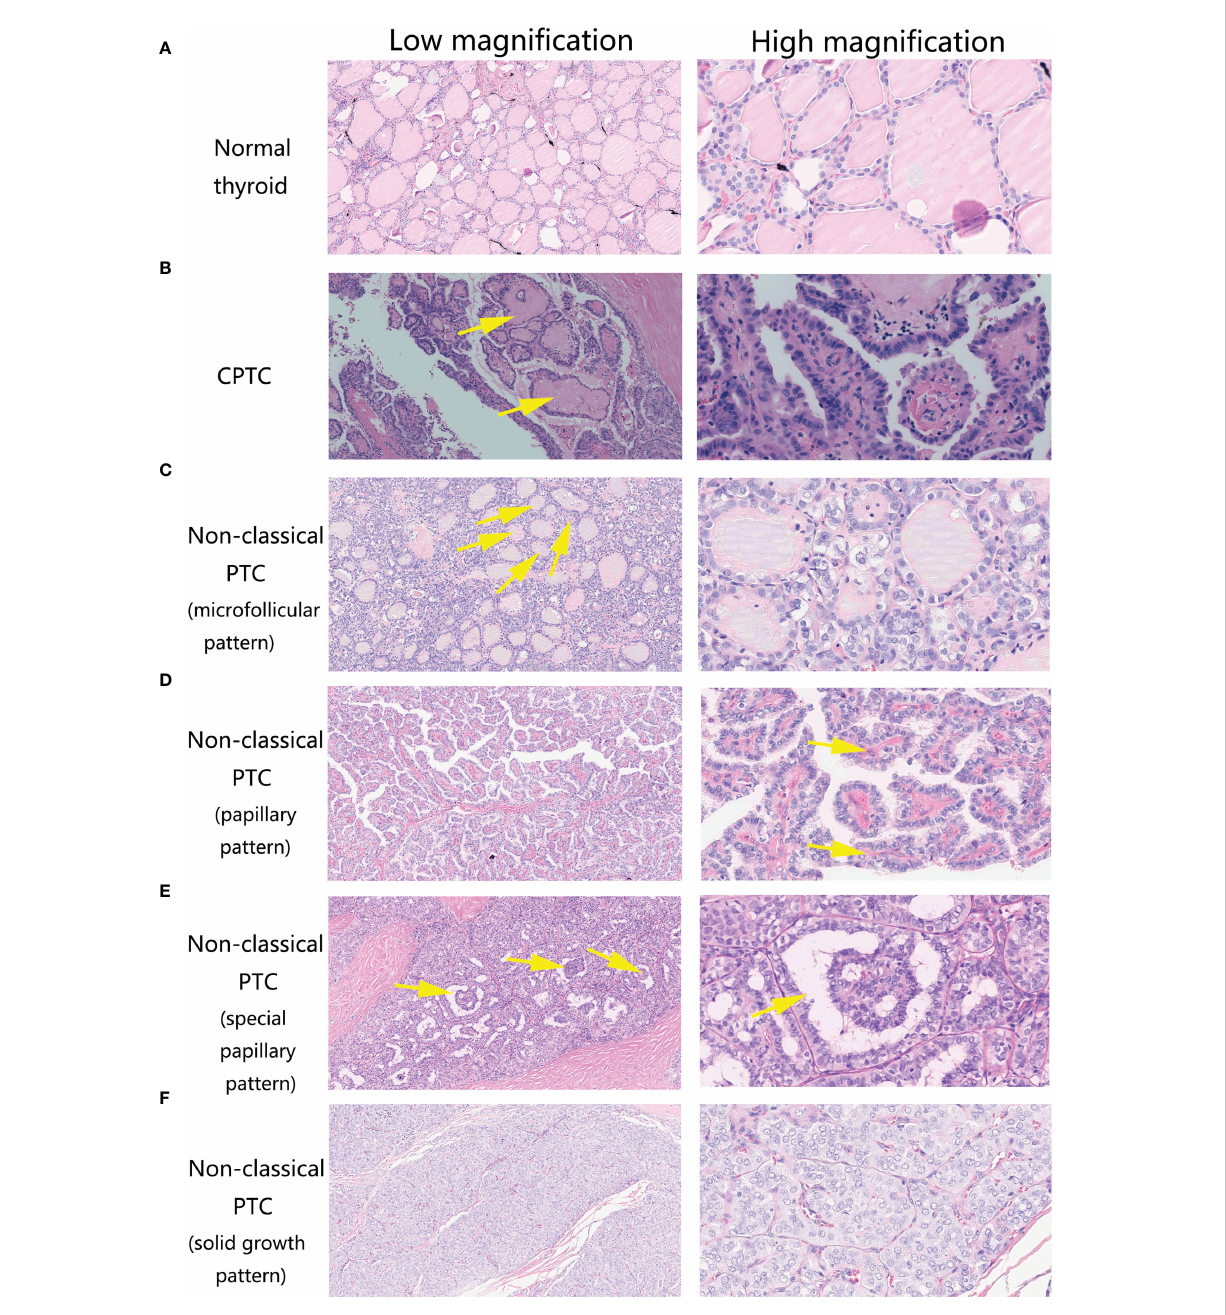
FIGURE 2 Growth patterns of Papillary Thyroid Carcinomas tumors with non-classical phenotype and controls in 100X and 400X magni fi cation. (A) Normal thyroid. (B) Classic PTC: low magni fi cation shows the papillae found in CPTC usually vary in size and shape and some have broader central stalks. The arrow shows the papillae with broader central stalks. High magni fi cation shows that the papillae composed of columnar epithelial cells. The nucleus has classic characteristics nuclear features of PTC and with signi fi cant elongation. (C) Dense microfollicles are composed of small cuboidal epithelia with round nuclei intermixed with some variable shaped nuclei. The tumor cells have transparent or pale cytoplasm with ill-de fi ned borders. Arrows show the microfollicles. (D) Tumor is dominantly composed of delicate papillae (arrow). (E) Occasionally tumors present glomeruloid bodies resembling abortive papillae. (F) Solid growth pattern, characterized by delicate fi brovascular cores within the solid nodules. The tumor cells have nucleus without signi fi cant